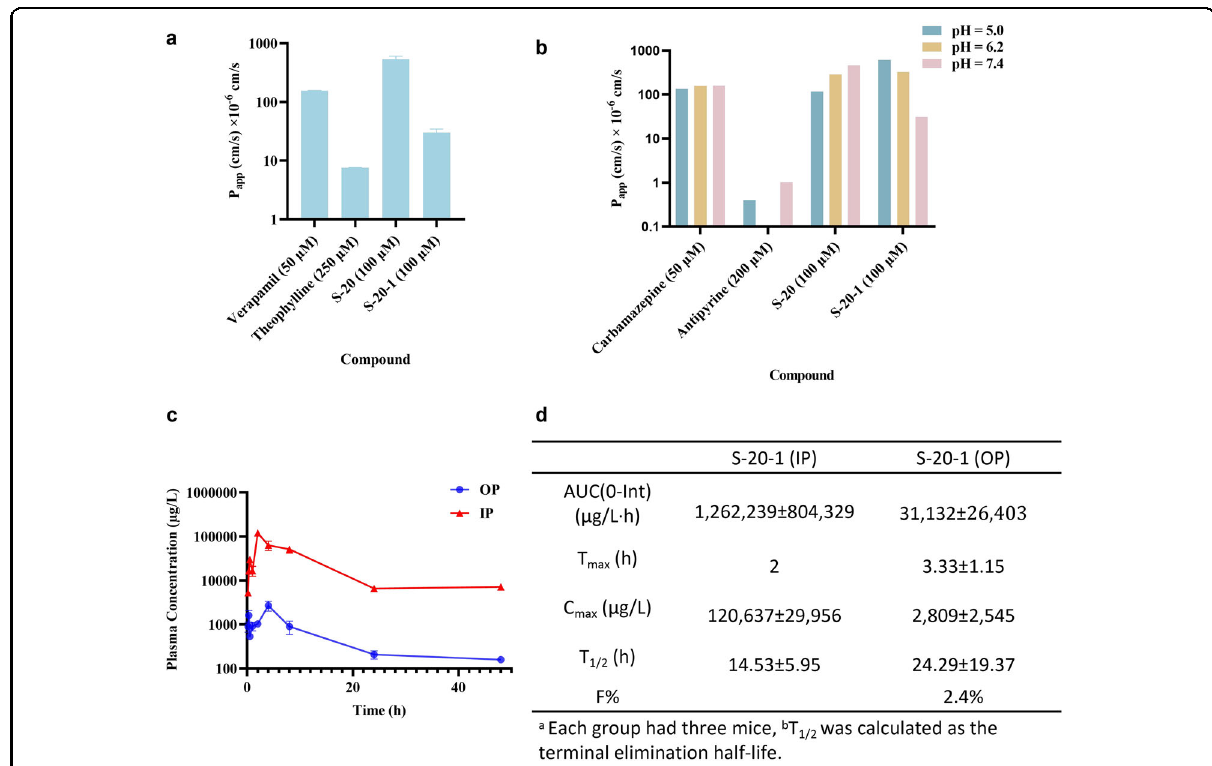
Fig. 8 Evaluation of membrane passive permeability, oral bioavailability, and PK pro fi les of S-20-1 in mouse model. a PAMPA-BBB assay for standards, S-20 , and S-20-1 at pH 7.4. b PAMPA-GIT assay for standards, S-20 , and S-20-1 at different pH conditions. c Time-concentration plot of S-20-1 in PK study. Plasma concentration and time curve following intraperitoneal (IP) (red) and oral administration (OP) (blue) administration of 50 mg/kg S-20-1 in C57BL/6 mice (data indicated are means ± SD, n = 3). d Pharmacokinetics parameters of S-20-1 over 48 h in